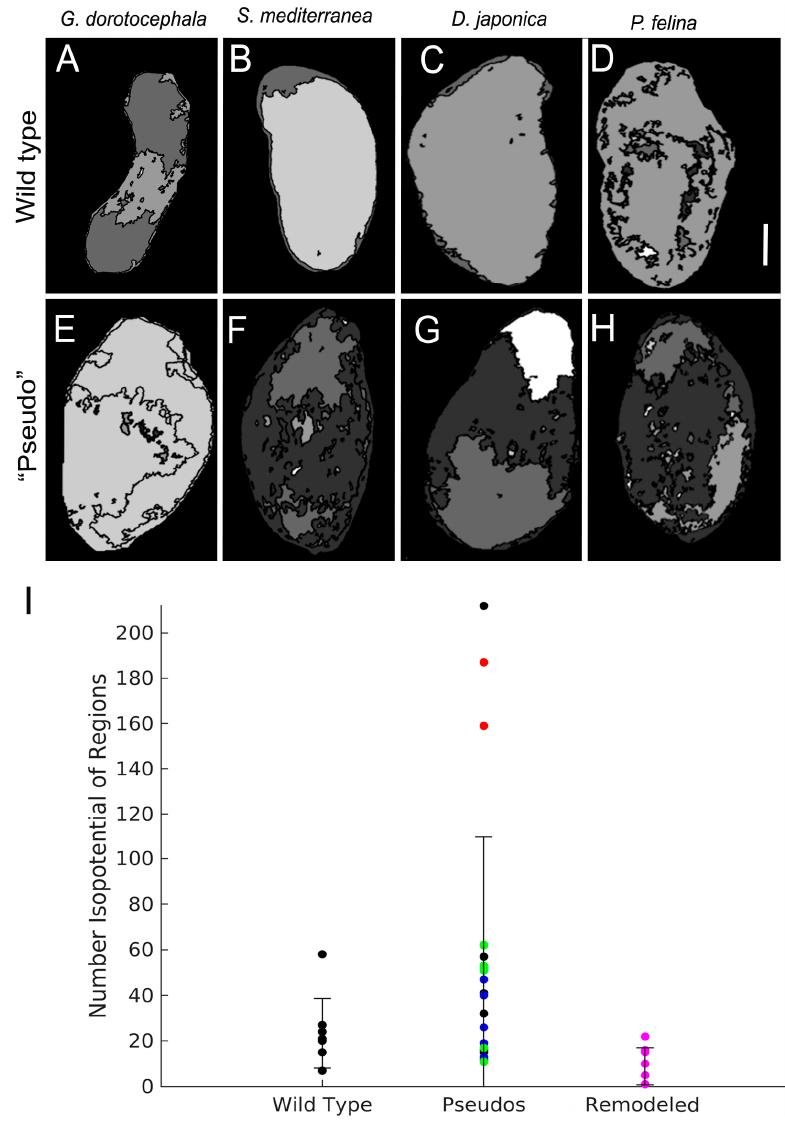
Figure 6. Membrane voltage reporter assay demonstrates long-term change of bioelectrical connectivity in octanol-exposed planaria. ( A – D ) Domains of relative membrane potential visualized using DiBAC 4 (3) in wild-type G. dorotocephala , wild-type S. mediterranea , wild-type D. japonica , and wild-type P. feline ; ( E – H ) Domains of relative membrane potential visualized using DiBAC(3) in pseudo G. dorotocephala (GDs), pseudo S. mediterranea (SMs), pseudo D. japonica (DJs), and pseudo P. felina (PFs), respectively. Scale bar 0.5 mm; ( I ) Number of isopotential regions in wild-type GD worms (control), all pseudo morphologies, and pseudo morphologies that have remodeled back to WT (wild-type) GD morphology after 30 days. After octanol treatment, the number of isopotential regions in pseudo morphologies is increased, but decreases to WT levels after remodeling. Black dots indicate worms with GD morphologies, blue dots indicate DJ morphologies, red dots indicate PF morphologies, green dots indicate SM morphologies, and pink dots indicate pseudo worms that have remodeled their morphologies to resemble wild-type GDs. n = 7 wild-type GD, n = 5 pseudo GD, n = 5 pseudo SM, n = 5 pseudo DJ, n = 2 pseudo PF, and n = 6 remodeled worms. Error bars are standard deviations. Non-parametric statistical analysis was done using a post-hoc comparison of all groups by Kruskal-Wallis test ( p = 0.0021), and then between groups using a Dunn’s Multiple Comparison test, which showed differences in voltage domain number between remodeled GDs and pseudo morphologies are statistically significant at p < 0.05.